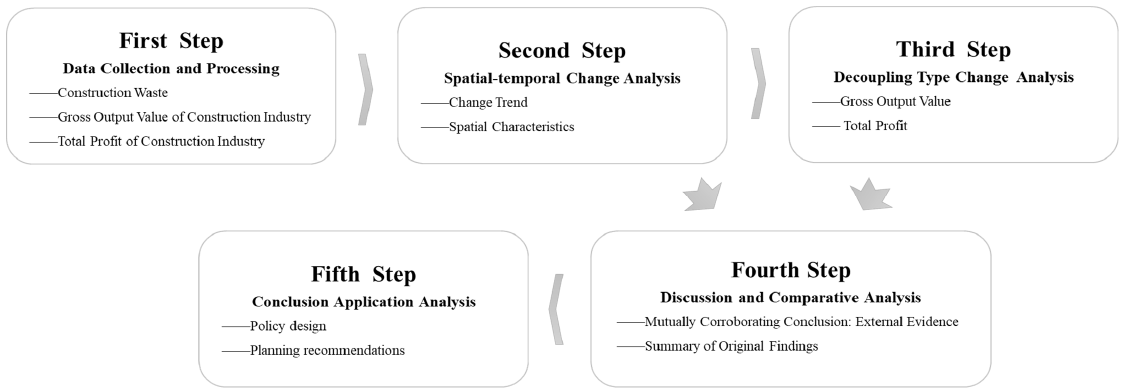
Figure 3. Research